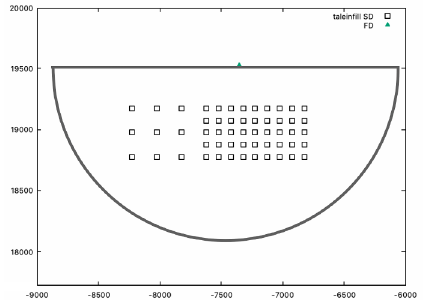
Figure 4: Core location distribution of Monte Carlo show- ers.